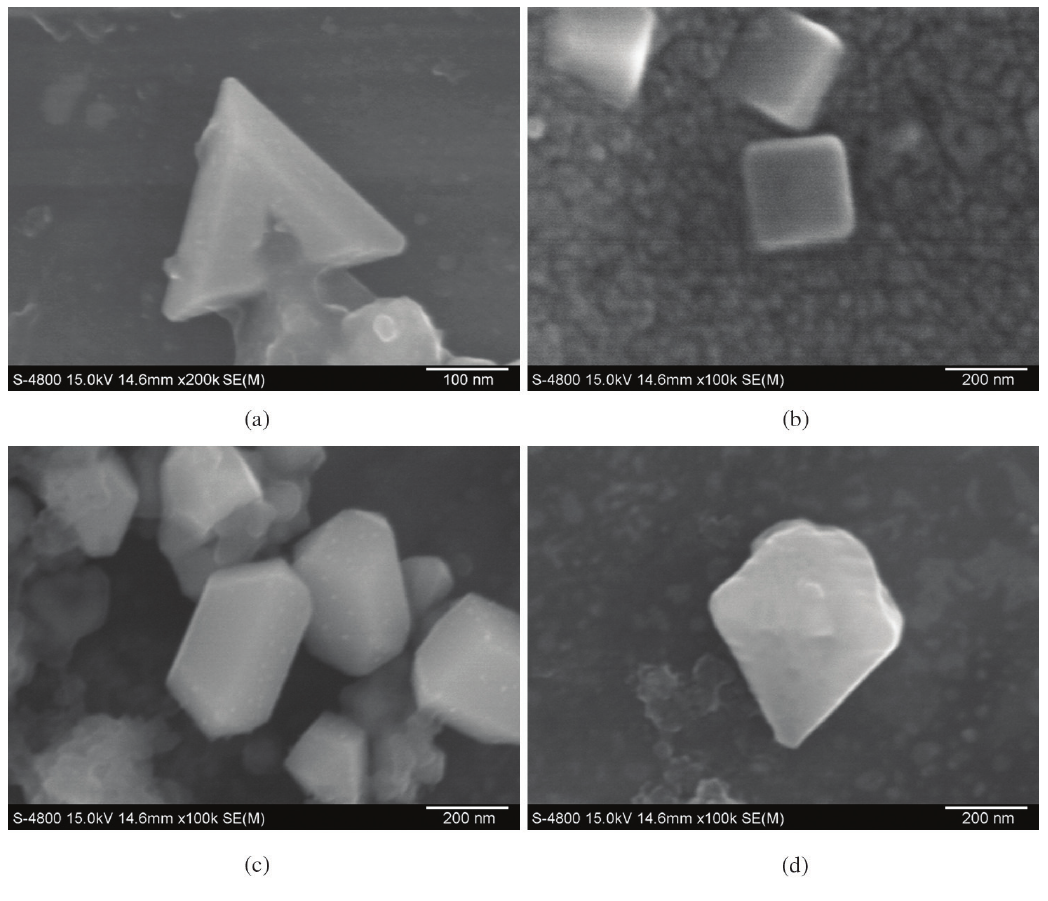
Figure 1. SEM images of the Cu